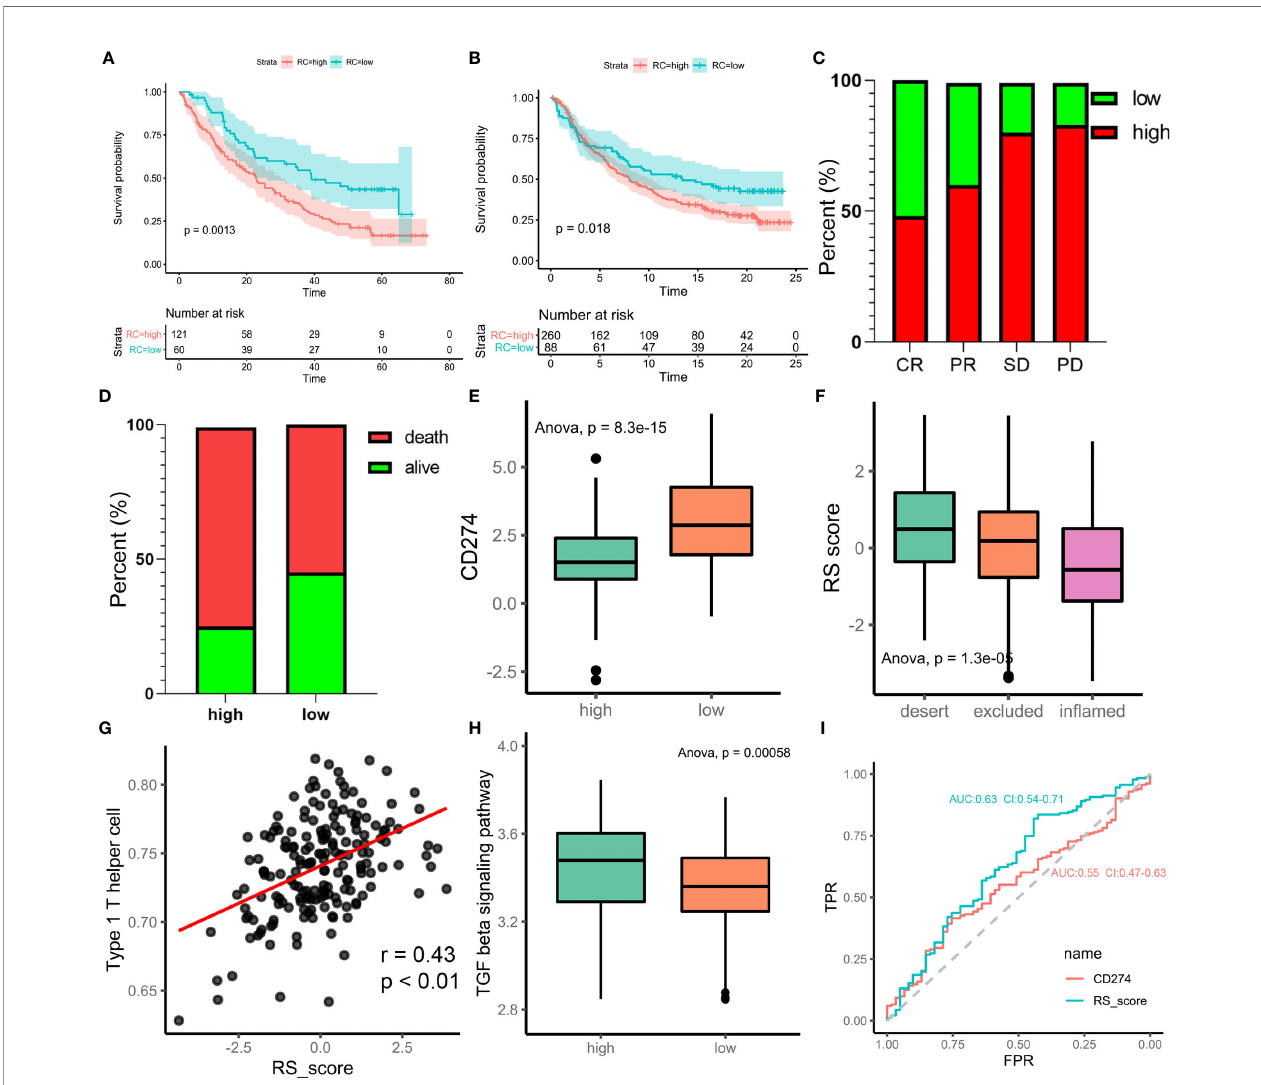
FIGURE 6 | m6A regulation patterns in the potential role of anti-PD-1/L1 immunotherapy. (A) Survival analyses for low-risk scores (60 cases) and high-risk scores (121 cases) using Kaplan-Meier curves (patients with Advanced ccRCC enrolled in prospective clinical trials of treatment with PD-1 blockade. P = 0.0013, Log-rank test). The prognosis of immunotherapy in high-risk scores cohort is poor. (B) Survival analyses for low-risk scores (88 cases) and high-risk scores (260 cases) using Kaplan-Meier curves (IMvigor210 cohort. P = 0.018, Log-rank test). (C) Differences of m6Ascore among CR, PR, SD, PD. (CR, complete response. SD, stable disease. PD, progressive disease. PR, partial response.) (D) Proportion of deaths difference between high and low risk scores. (Chi-square test, p<0.0001) (E) Differences of CD274 between high and low risk score groups. (F) Difference of risk score among tumor immune micro-environments (desert, excluded and in fl amed). (G) scatter diagram shown the correlation between Type 1 T helper cell and risk score. (H) Difference score of TGF beta signaling pathway between high and low of m6Ascore in TCGA prostate cancer database (high m6Ascore group marked with green. low m6Ascore group marked with red. t.test, p<0.001). (I) Receiver operator characteristic curve (ROC) of CD274 and RS score represented prediction ef fi ciency of anti-PD-1/PDL1 immunotherapy by risk